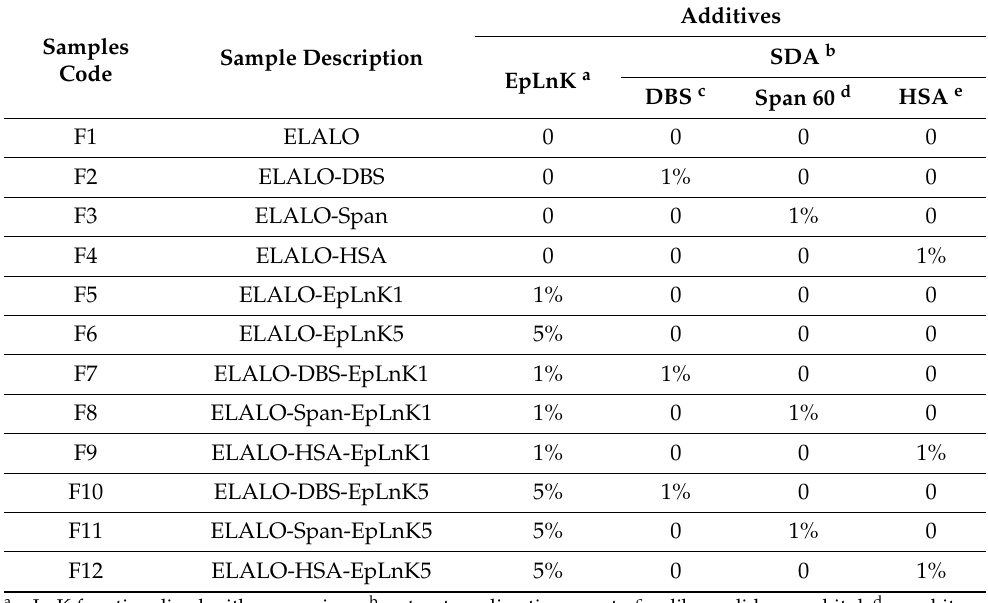
Table 1. Feed composition of the ELALO-based formulated